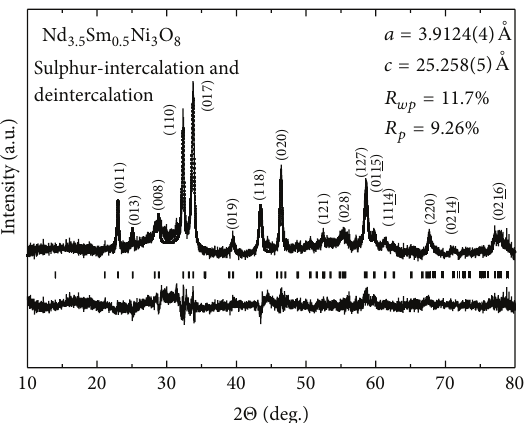
Figure 4: Temperature dependence of Nd 3.5 Sm 0.5 Ni 3 O 8 and sulfur